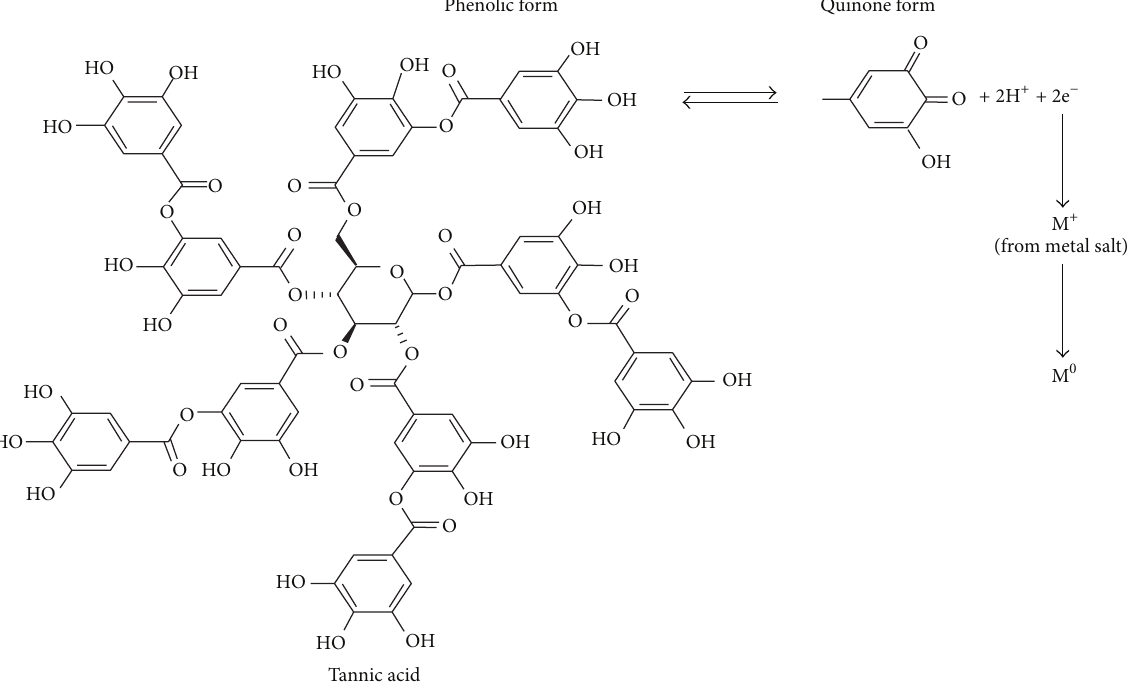
Figure 2: Reaction mechanism of tannic acid based reduction of metal salts. The phenolic groups in the tannic acid get oxidised to quinones with subsequent release of electrons which reduce the metal